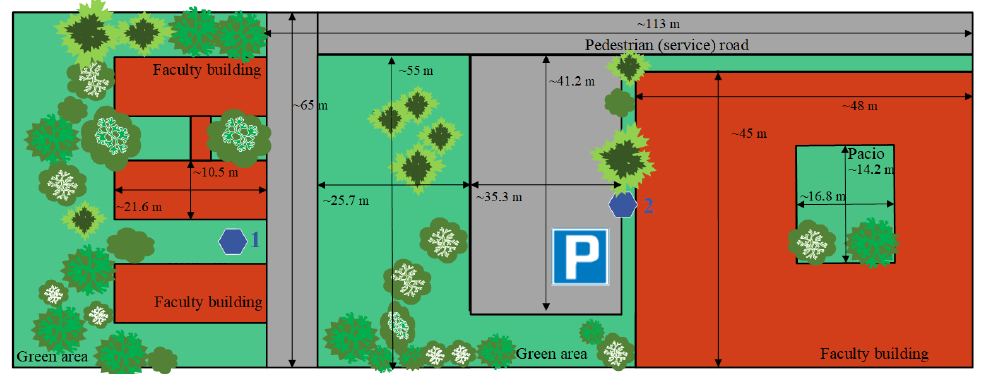
Figure 1. Position of the sensors. The data for May 2018 was collected by sensor 1, while sensor 2 collected the data for May 2020, May 2021, and May 2022. In the immediate vicinity of the sensors, the existing plants are mostly deciduous flowering plants, but there are also evergreens. In particular, there are 43.2% trees of the Tillia type, 32.4% trees of the Populus type, and 24.3% trees of the Deodar cedar